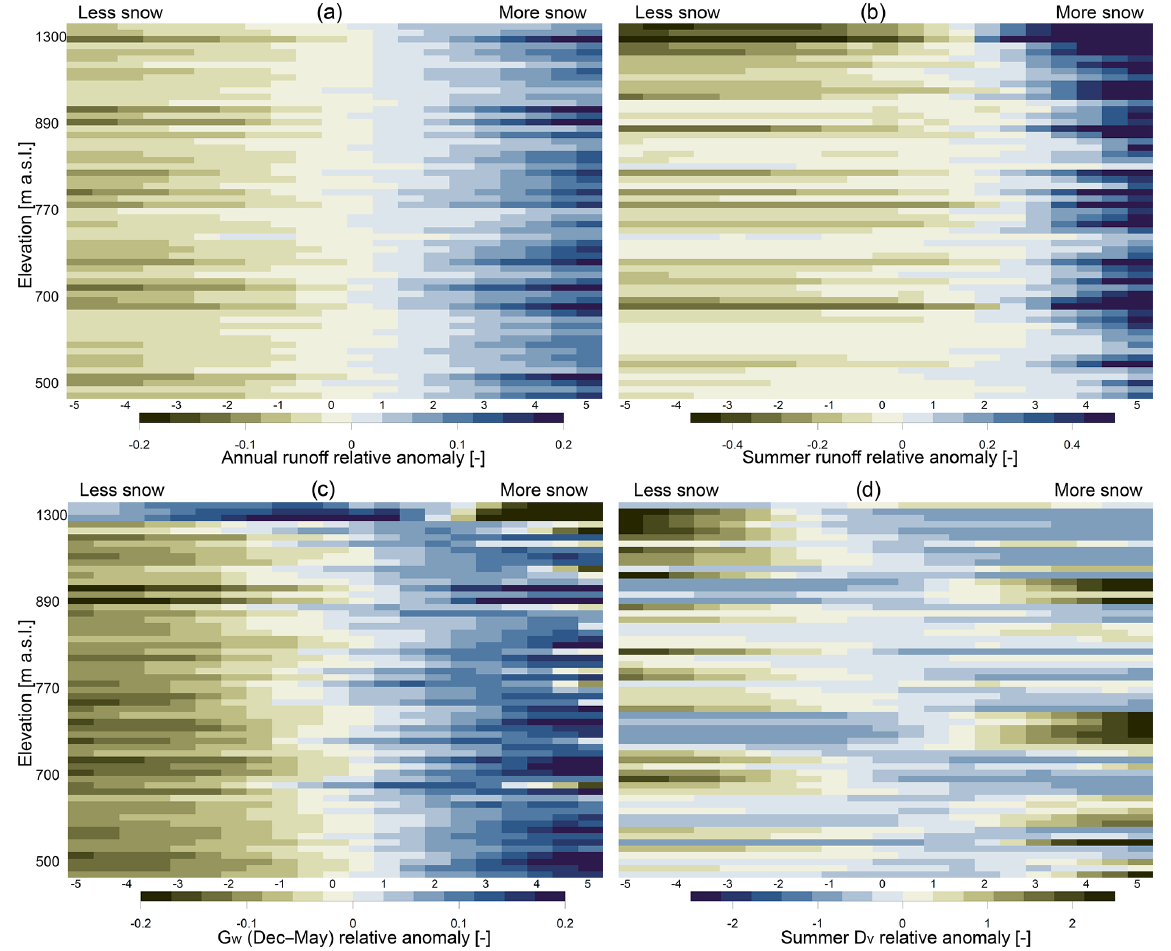
Figure 8. Relative change of selected signatures with increasing T T for study catchments: (a) annual runoff, (b) summer (June–August) runoff, (c) groundwater recharge (December–May) and (d) summer (June–August) deficit volumes. Rows represent individual catchments sorted from top to bottom according to mean catchment elevation from highest to lowest ( y axis not to scale); columns represent T T used in model simulations. Colours show normalized values relative to their means (different scales used for individual